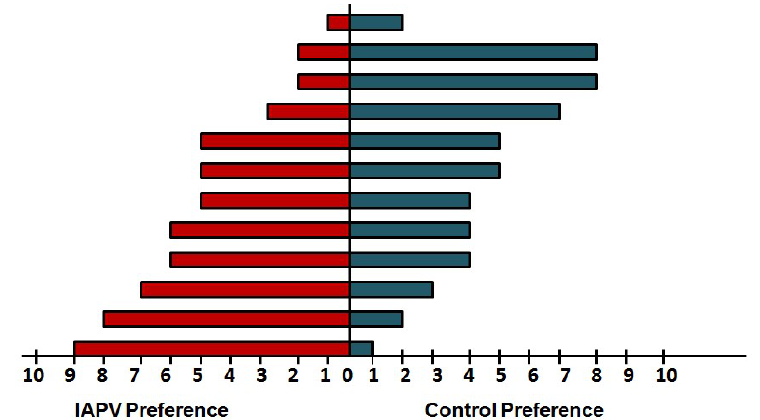
Figure 1. Worker preferences for Israeli Acute Paralysis Virus (IAPV)-exposed or control queens. For each queen pairing, ten independent workers were placed in a two-way olfactometer to choose between odors coming from an IAPV-inoculated (left) and sham-treated control queen (right) for ten minutes. Although workers chose the IAPV-inoculated queen significantly more than the control queen in one pairing (bottom bar), no overall preference according to experimental treatment was observed across all pairings.